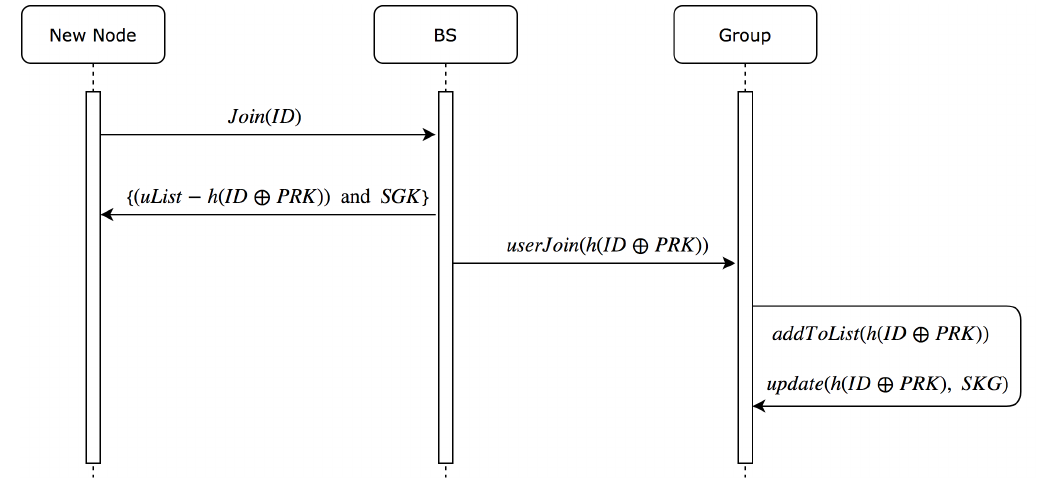
Figure 4. Sequence diagram for joining node